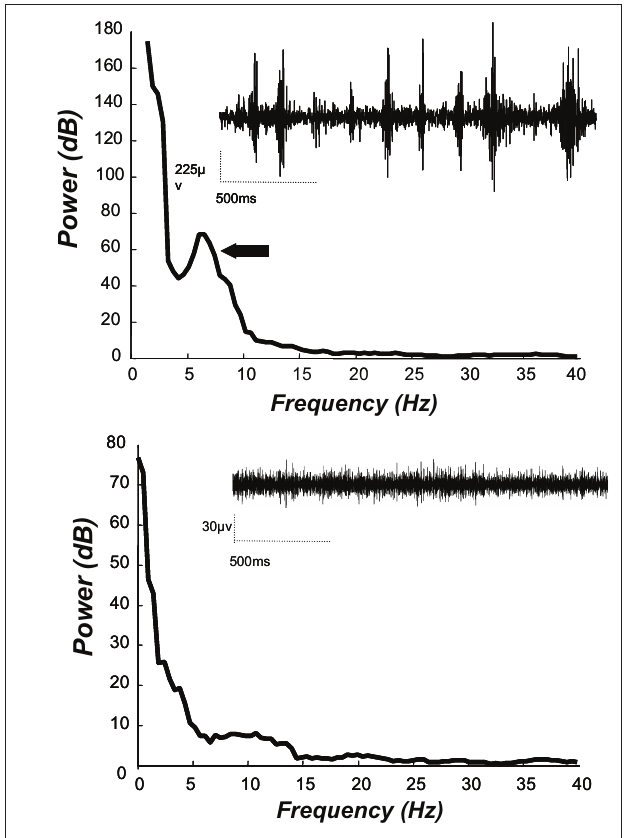
Figure 2 | electromyography (eMg) from temporalis muscle in rats injected with 0.5 mg/kg of the muscarinic agonist pilocarpine (iP). Raw EMG traces and spectral analyses of the EMG data during periods with tremulous jaw movements (top) and without tremulous jaw movements (bottom). During bouts of jaw movement activity, rats show bursts of muscle activity (raw EMG trace, bottom left); spectral analyses revealed a peak in the 5 to 6-Hz frequency range for this